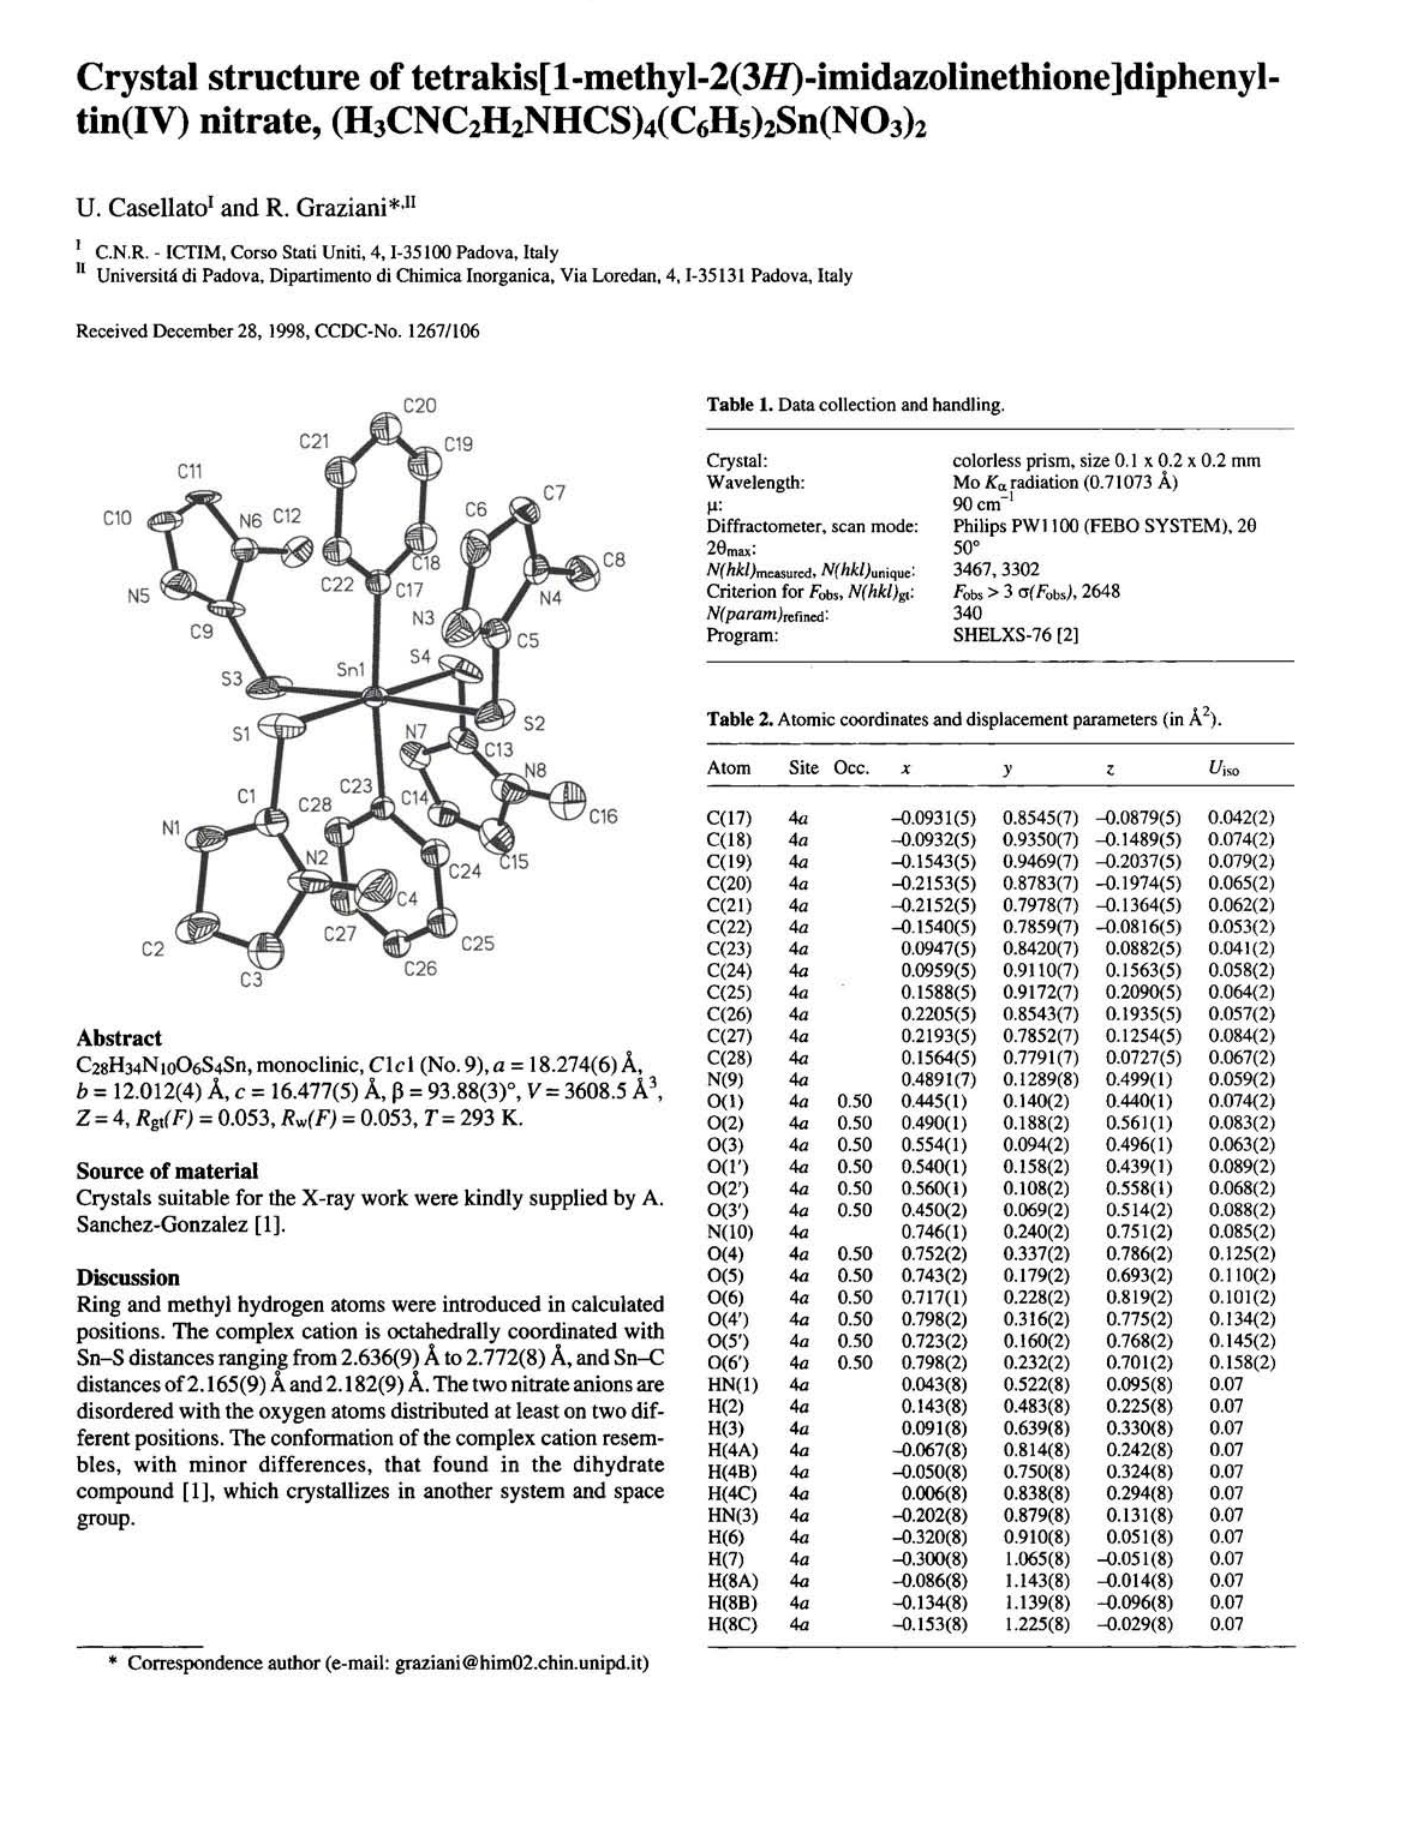
Table 1. Data collection and handling.